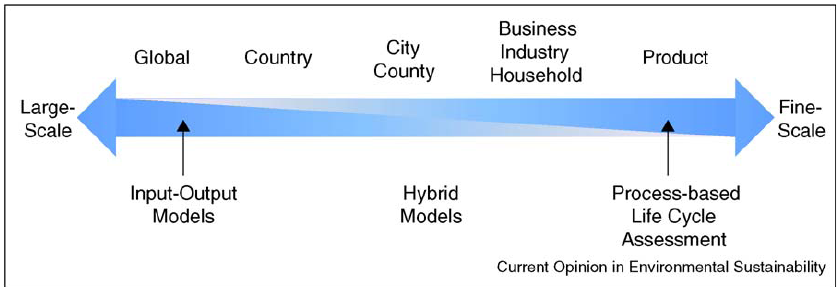
Figure 1. Carbon footprint (CF) applications/corresponding methods across scales